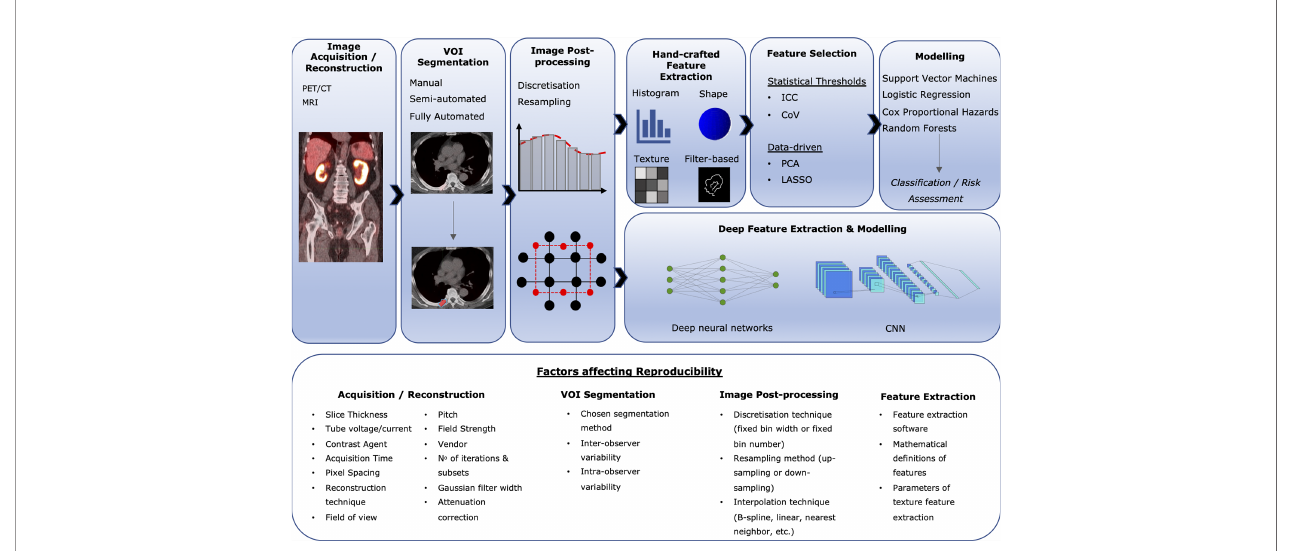
FIGURE 1 | Overview of the radiomics work fl ow, with a non-exhaustive list of some critical factors affecting feature